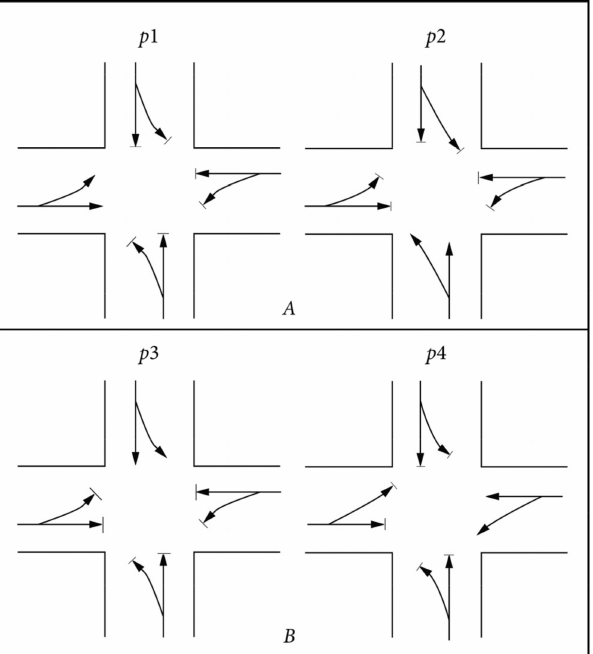
Figure 2. Phase diagram. ( A ) East import and south import phase. ( B ) East import and south import